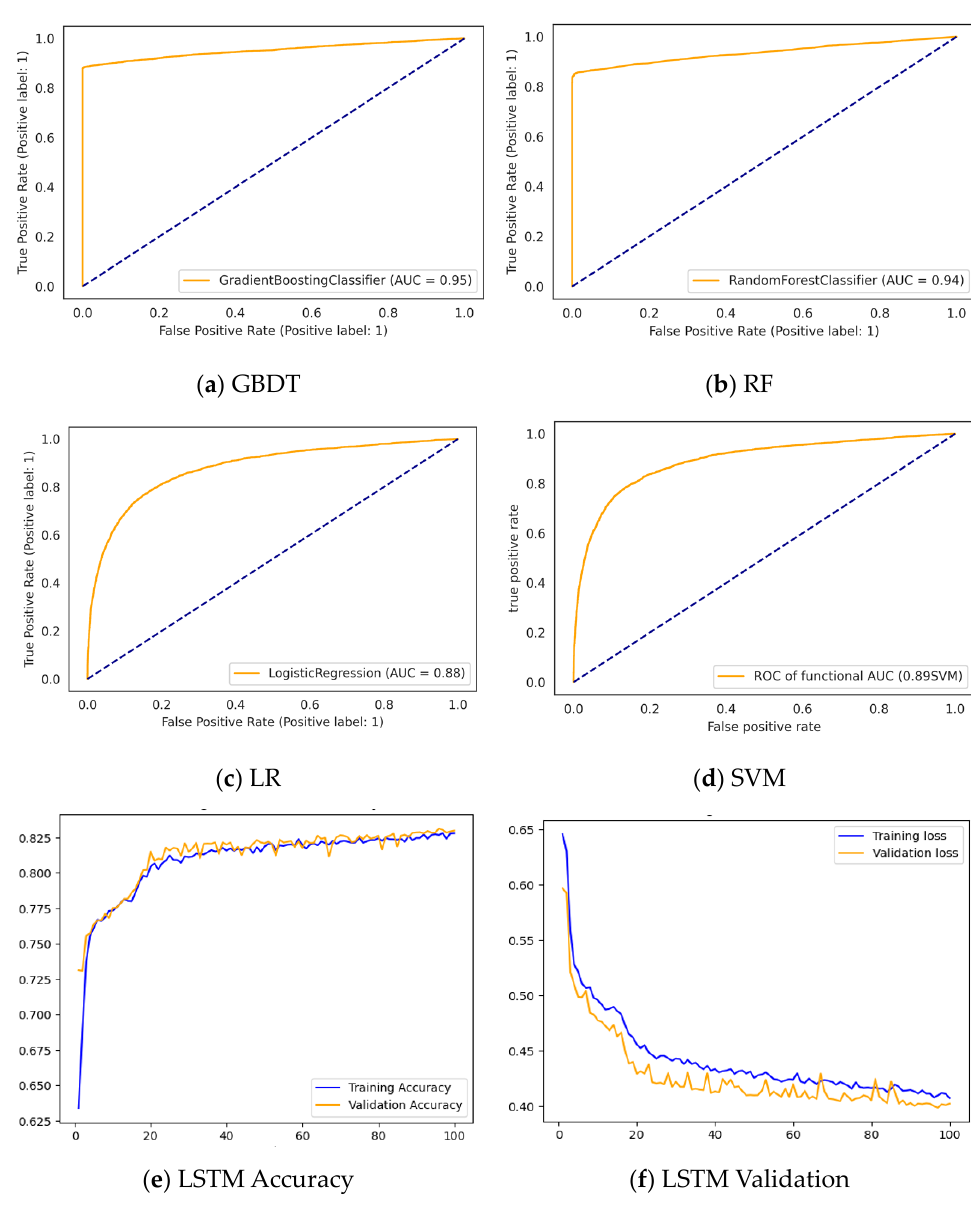
Figure 4. Evaluation of different models using ( a – d ) ROC curve of the classifiers trained using the subsets. ( e , f ) Training vs. validation loss LSTM.